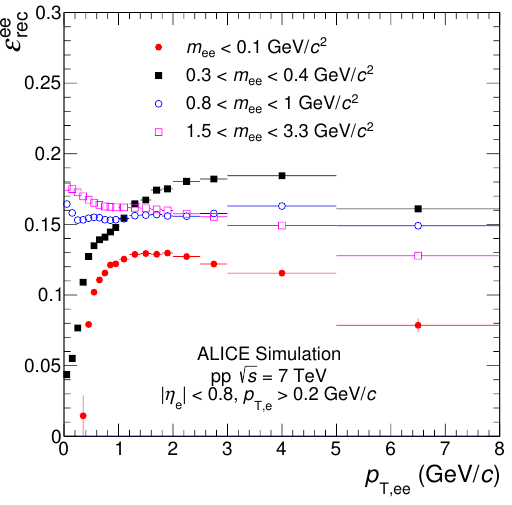
Figure 7 . Pair e(cid:14)ciency as a function of p T ; ee for di(cid:11)erent m ee intervals for the default electron selection